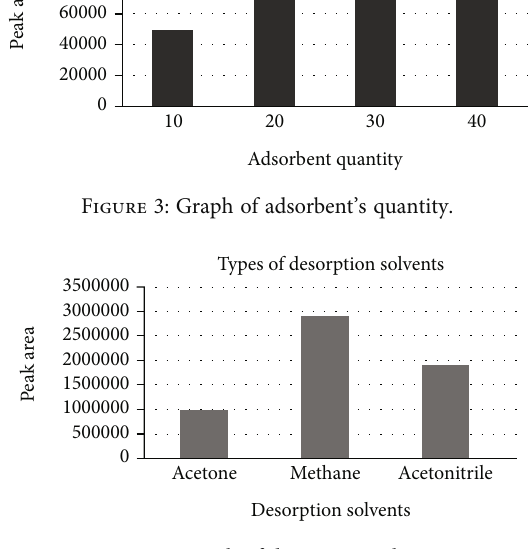
Figure 4: Graph of desorption solvents.